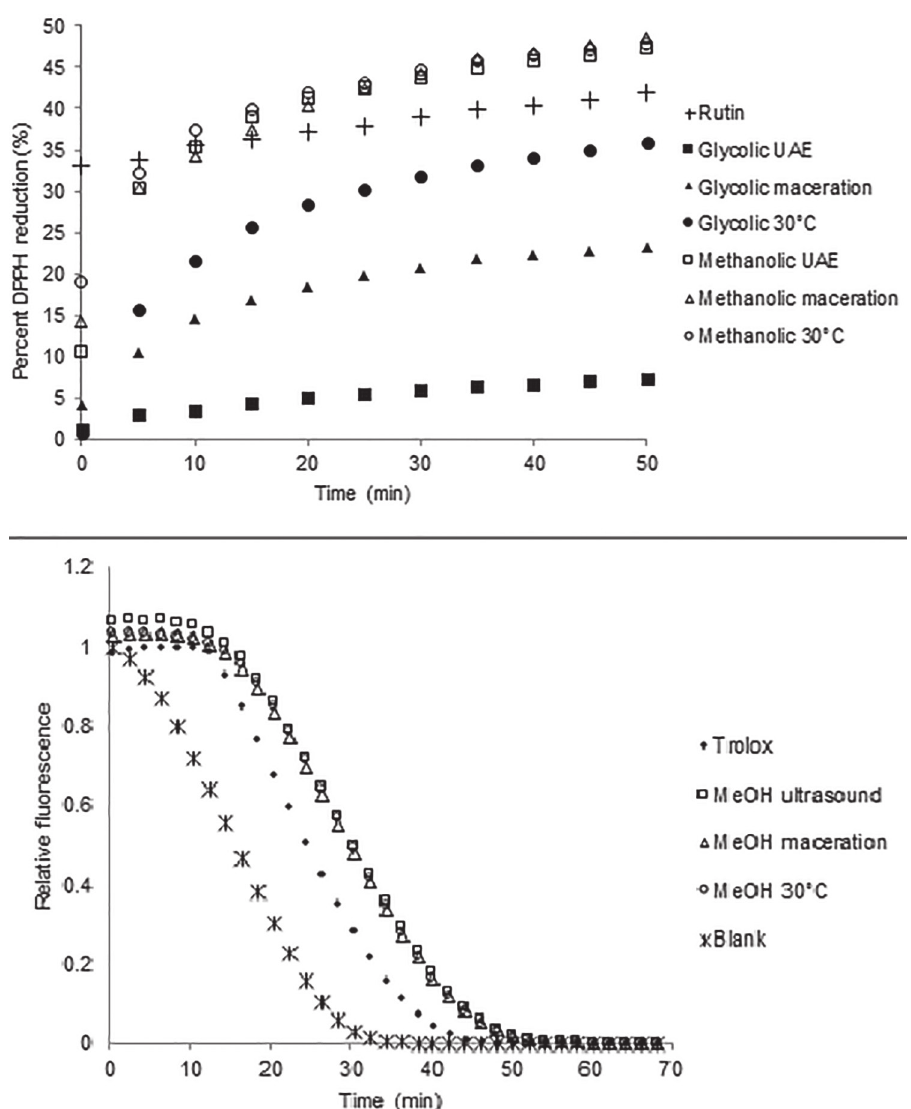
FIGURE 1 - Top: DPPH reaction kinetics. Extracts concentration: 12.5 µg mL -1 . Rutin: 6.2 µg mL -1 . MeOH: methanolic extract. PPG: glycolic extract. Bottom: Fluorescence decay of te methanolic extracts in ORAC-FL